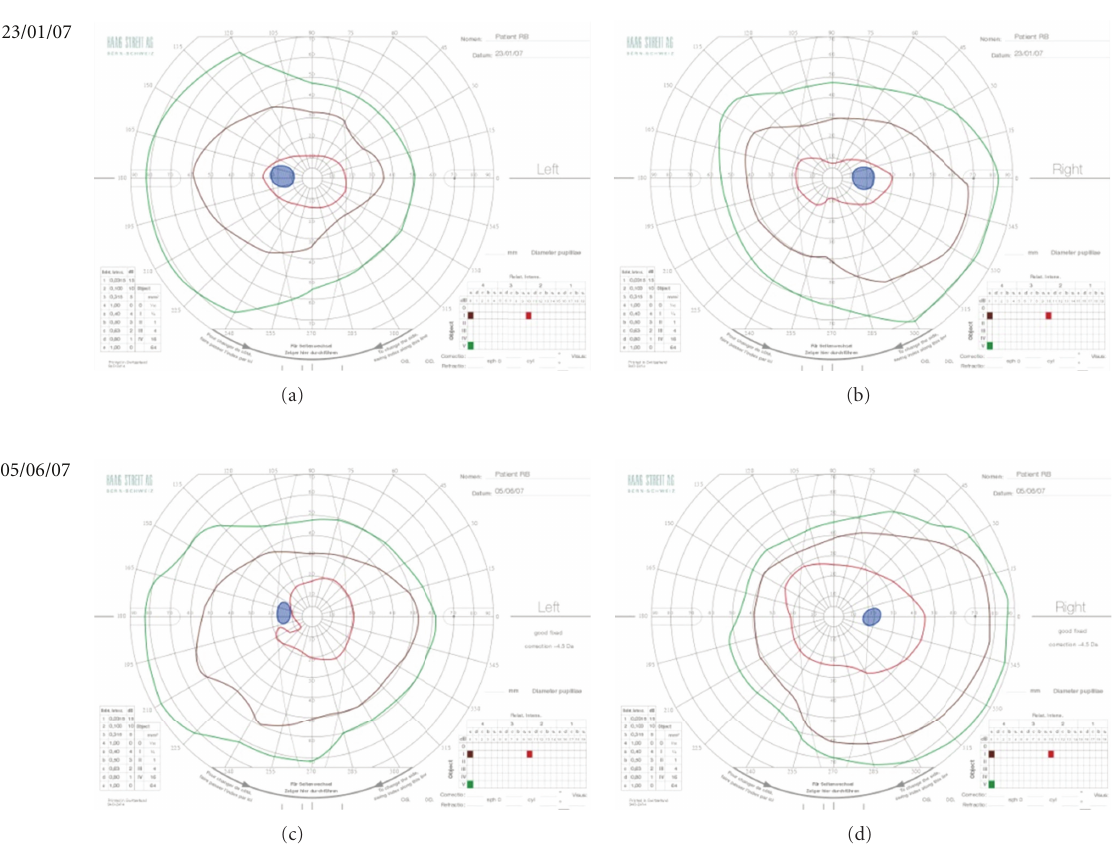
Figure 6: Goldmann visual fields showing minimal change in the left eye 1 month after a recurrent episode of optic nerve swelling (c) compared with visual fields performed 4 months before this recurrence (a). The contemporaneous right visual fields (b and d) are presented for